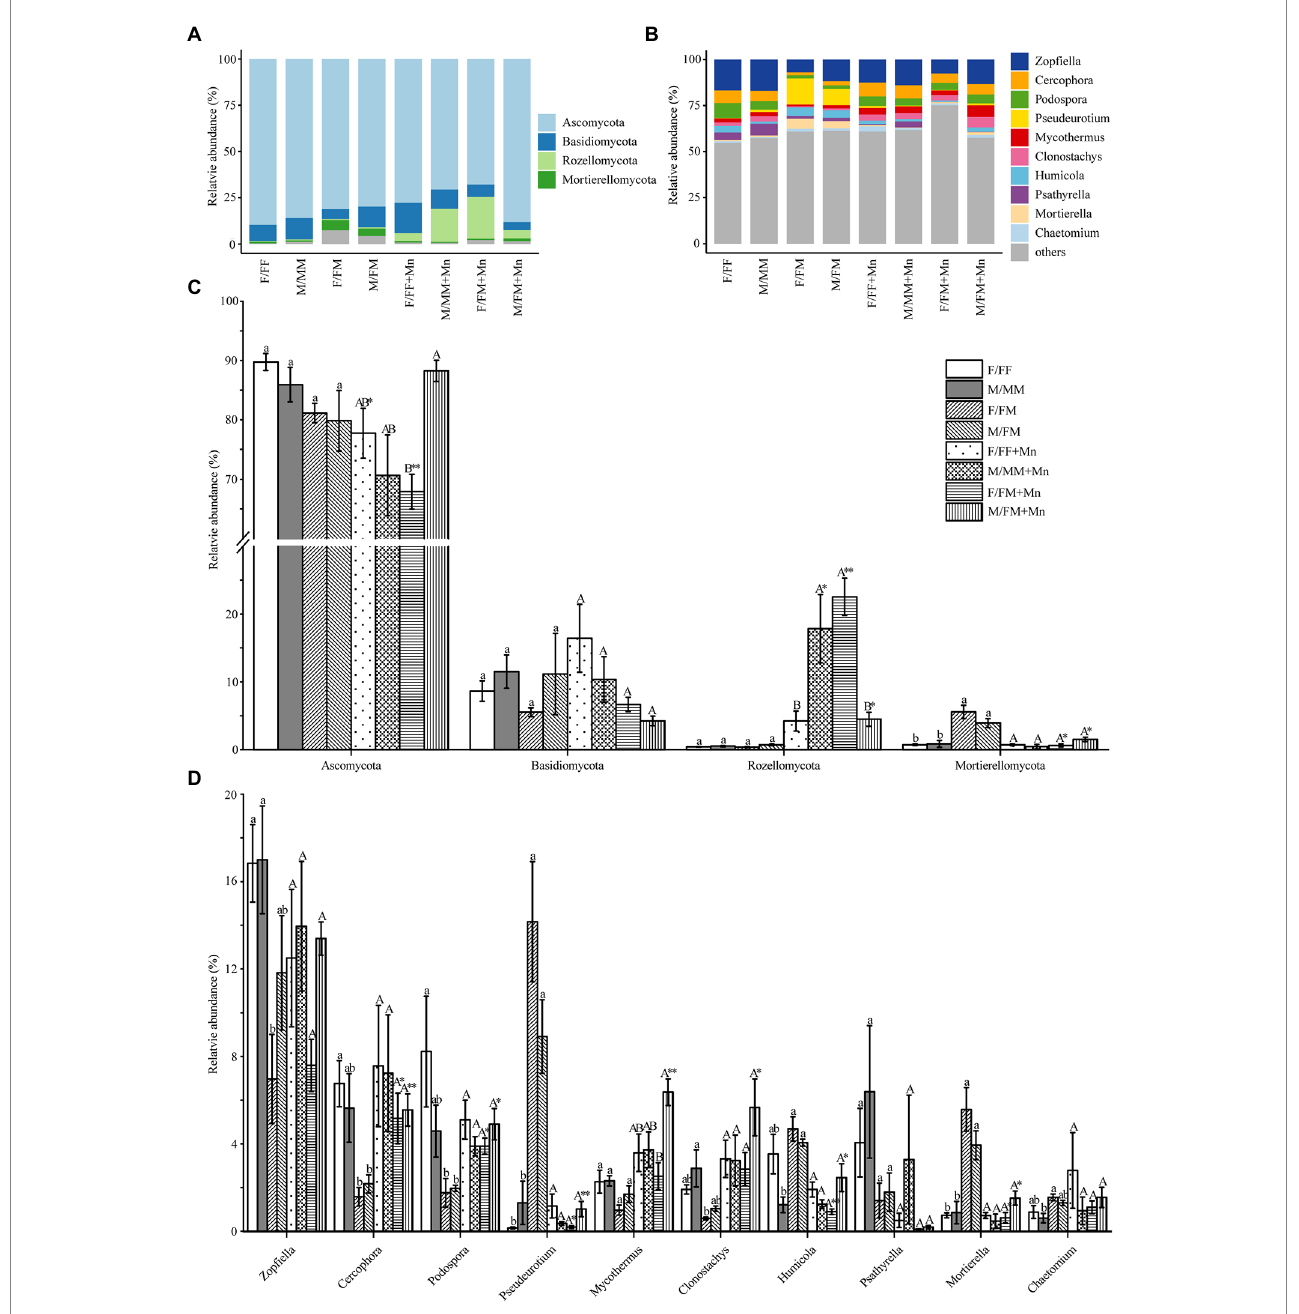
FIGURE 2 Relative abundances of dominant fungal phyla (A , C) and genera (B , D) under different sexual competition patterns and Mn treatment. Different lowercase letters mean significant differences under control conditions, and different uppercase letters mean significant differences under Mn treatments, according to Tukey’s test ( p < 0.05). The asterisks indicate significant differences between control and Mn treatments within each competition treatment according to an independent-samples t -test (* p < 0.05, ** p ≤ 0.01, *** p ≤ 0.001). Values are means ± SE ( n = 4). Treatment codes are the same as in Table